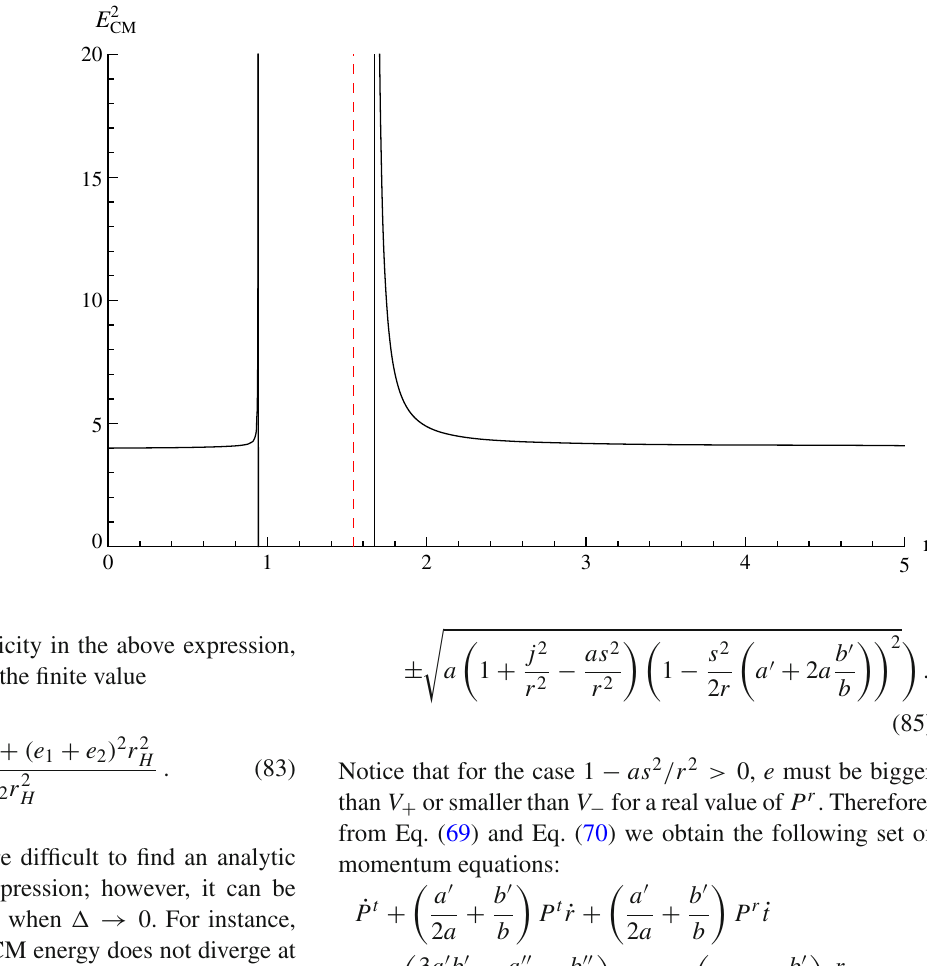
Fig. 9 The behavior of E 2 a function of r , for a 1 = − 2, b 1 = 1, s 1 = 1, s 2 = 2 . 5, e 1 = e 2 = j 1 = j 2 = 1, m 1 = m 2 = 1 and σ = 0 . 1. The red line corresponds to the event horizon radius r H ≈ 1 . 54. E 2 diverges at the spin-related